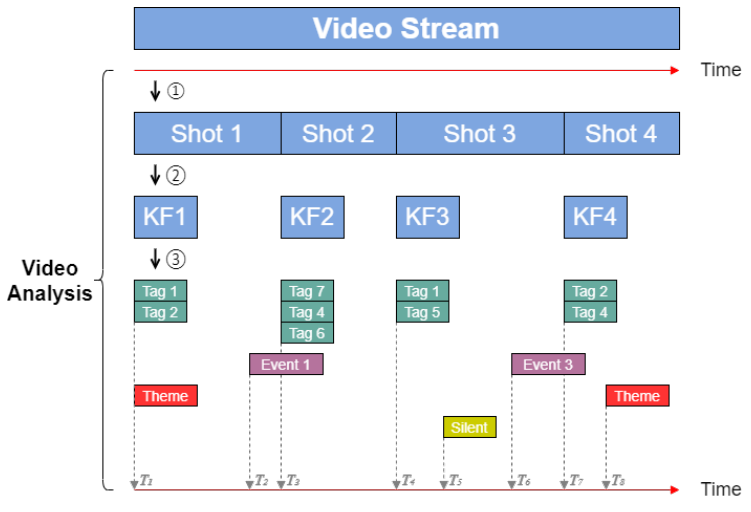
Figure 1. Video analysis